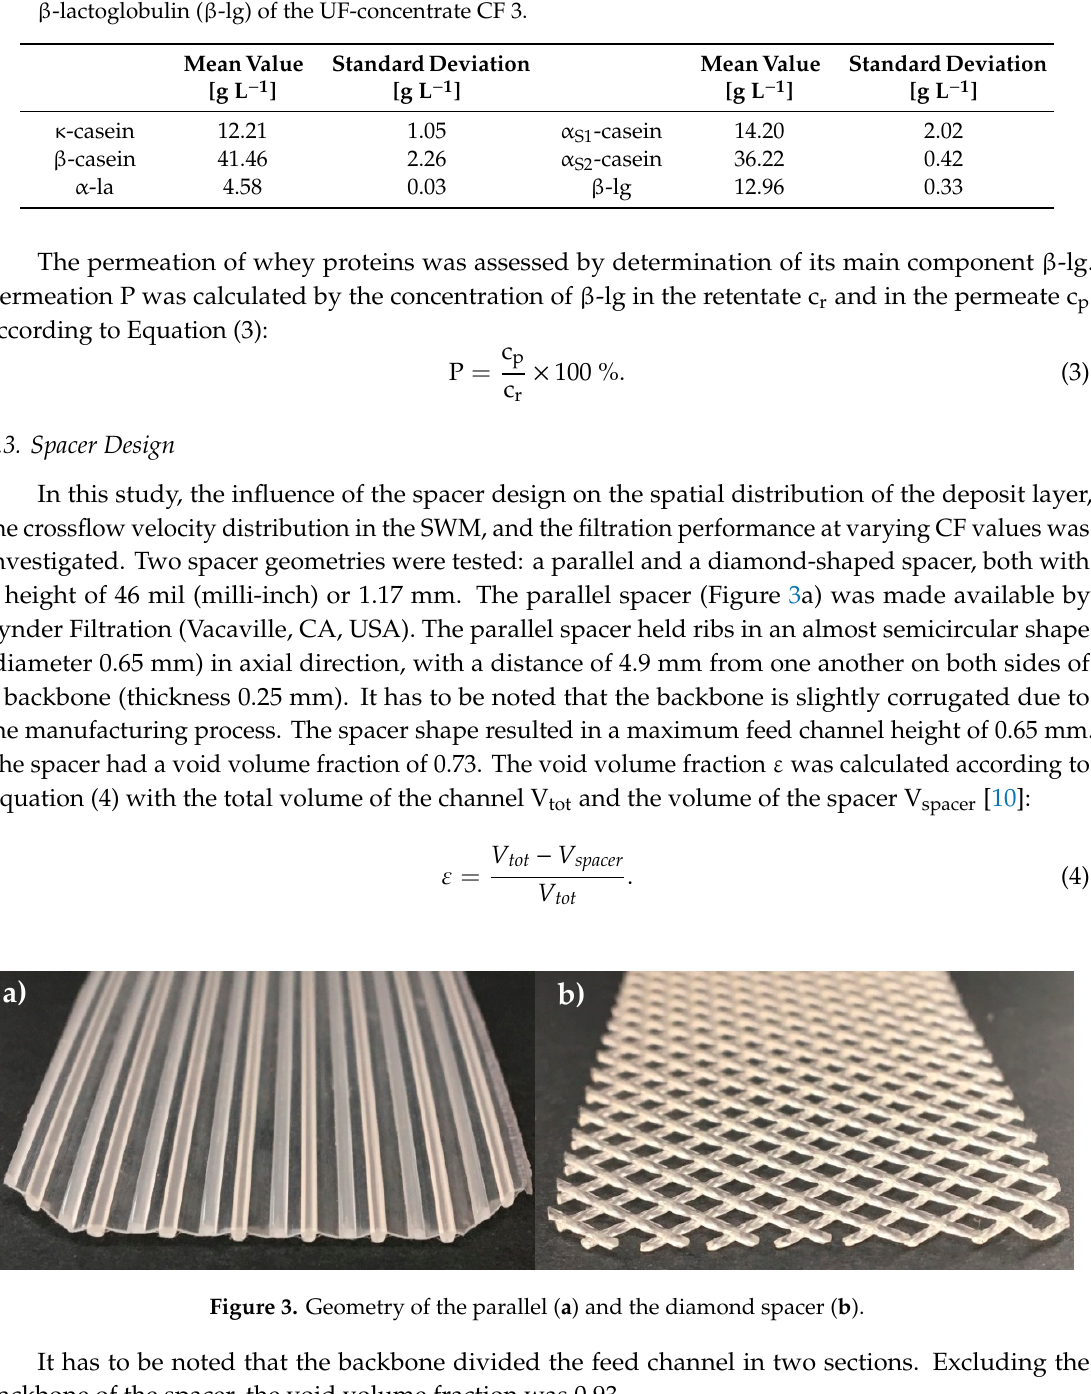
Table 2. Mean composition of the caseins and major whey proteins α -lactalbumin ( α -la) and β - lactoglobulin ( β -lg) of the UF-concentrate CF 3.